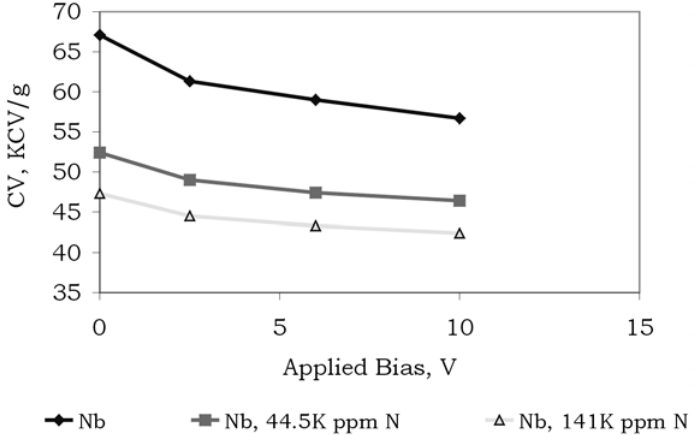
FIGURE 5 Behaviour of nitrided Nb anodes (annealed at 350 (cid:4) C =